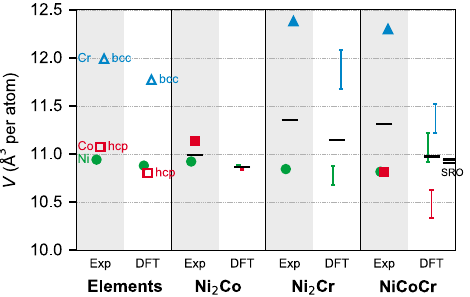
Fig. 4 Apparent volumes of Ni (green), Co (red), and Cr (blue) in various fcc alloys from room temperature experiments and DFT. The error bar in DFT data indicates the 95% con fi dence interval in the linear regression in the mis fi t volume calculation. Black bars are the alloy atomic volumes. All the results are from fcc structure unless indicated and shown as